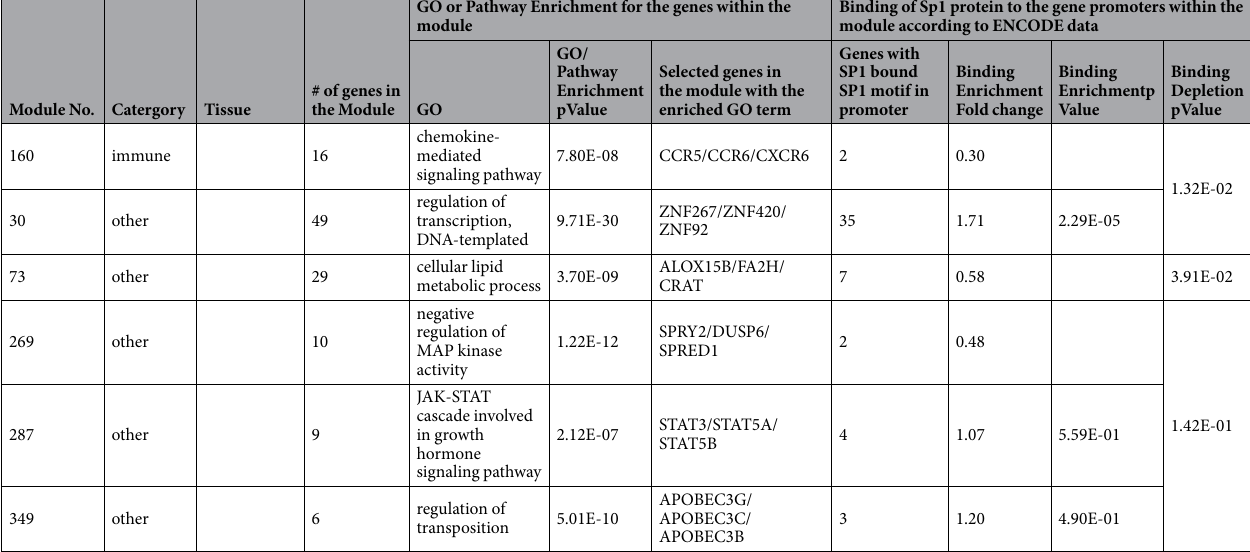
Table 2. Sp1 motif-regulated modules. Note: * denotes enriched